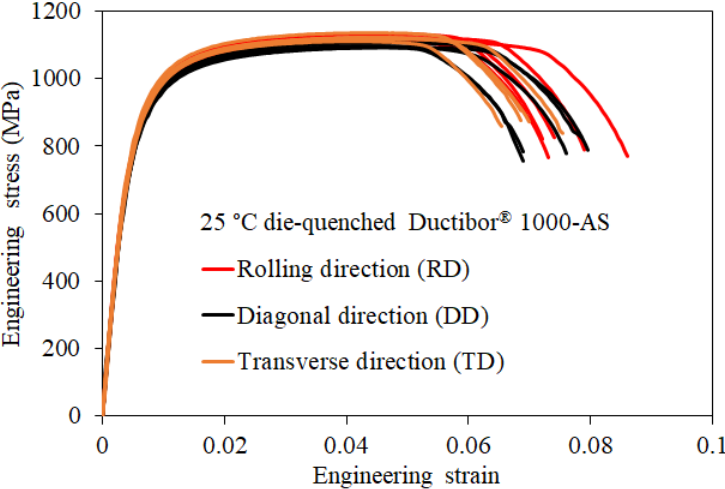
Figure A1. The engineering stress-strain response of the 25 °C die-quenched condition of Ductibor ® 1000-AS in the sheet principal directions. Table A1. The anisotropic properties of the 25 °C die-cooled condition of Ductibor ® 1000-AS.